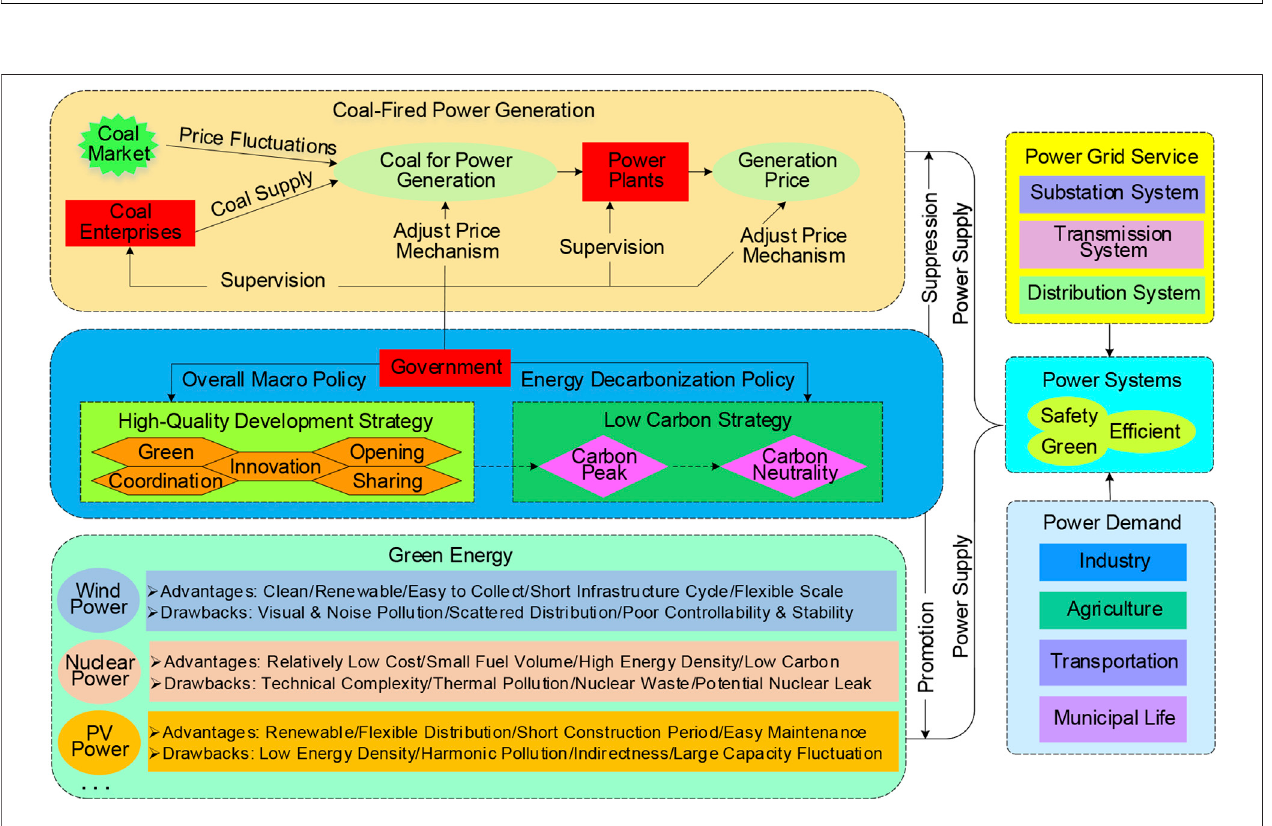
FIGURE1| Timeevolutionarycharacteristicsofcarbonemissions,powerproductionandconsumption,andcoalproductioncapacityinChina.Source:1)Thedata oftotalCO 2 emissionsandSEC_TEwereobtainedfromCSMARCarbonNeutralityResearchDatabase;2)ThedataofTRCPcamefromCHINAENERGYSTATISTICAL YEARBOOK 2020; 3) The vast majority of the data for SRCCP_CP and SP_EEC were obtained from CHINA ELECTRICITY STATISTICAL YEARBOOK 2021, except for the data from 2001 to 2004 obtained by linear interpolation.